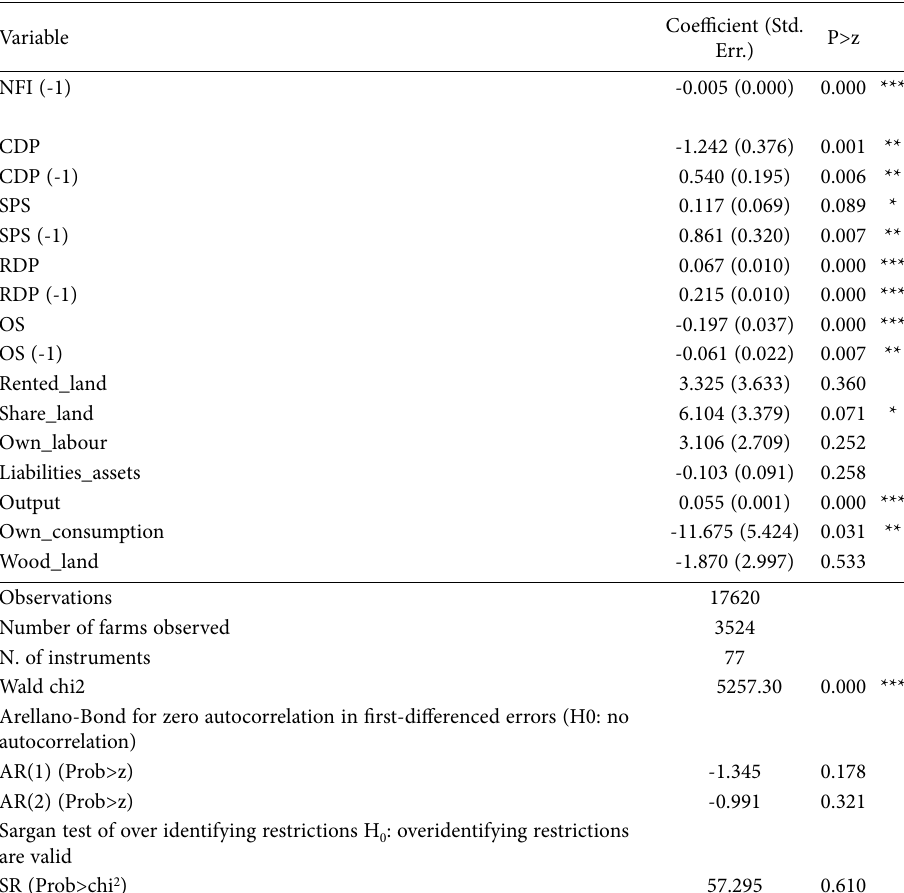
Table 2. Arellano-Bond (first difference) dynamic GMM estimator: results (estimates based on period